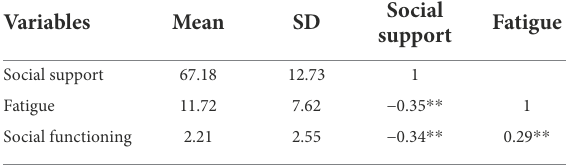
TABLE 2 Means, SDs, and correlations of all